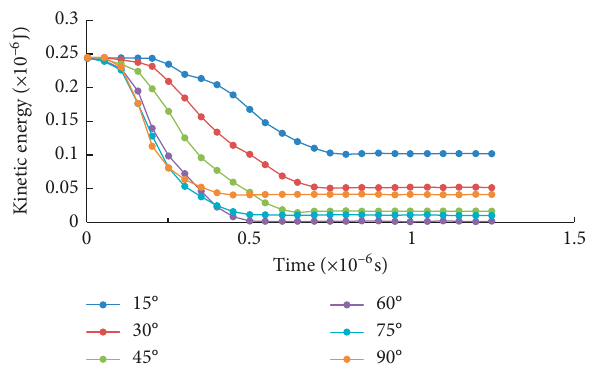
Figure 6: Change of kinetic energy of particles with time.